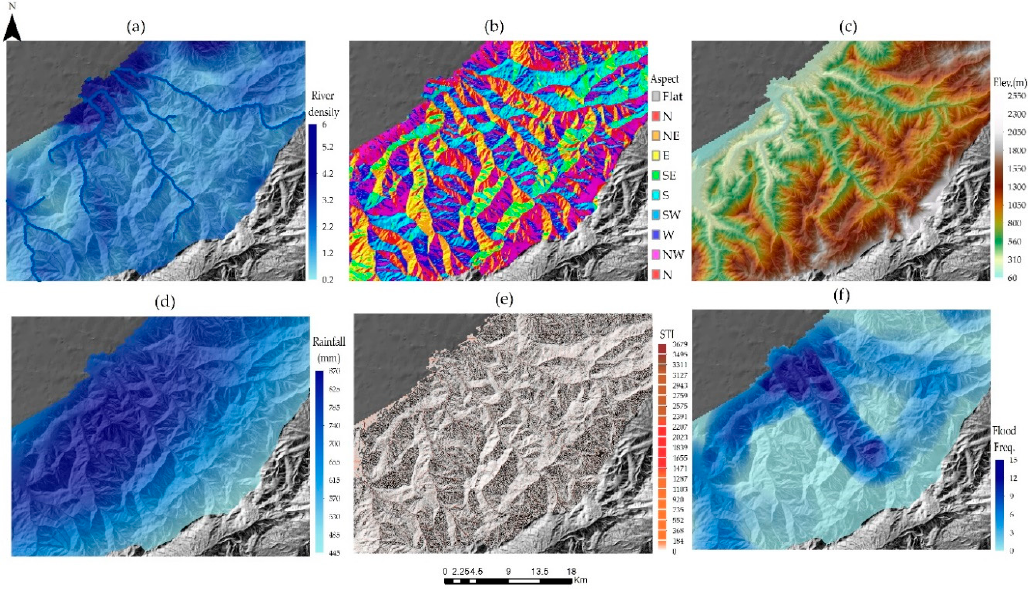
Figure 7. The layers of the top influential factors that control landslide susceptibility in the non-protected forest in NE Iran: river density ( a ); aspect ( b ); elevation (Elev.) ( c ); rainfall ( d ); sediment transport index (STI) ( e ); and flood ( f ).